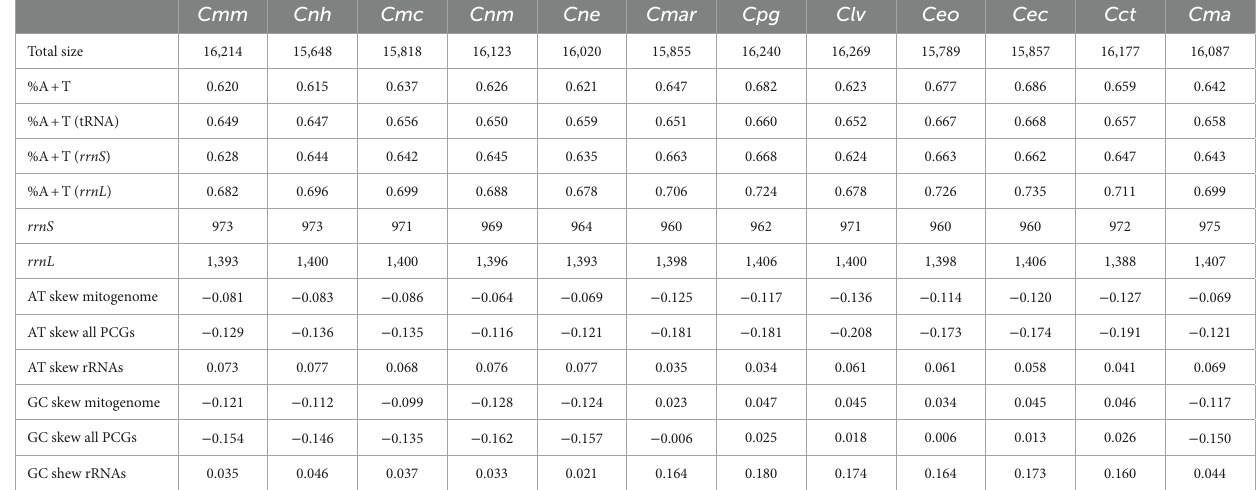
TABLE 2 List of total size, AT content, AT skew and GC skew, for mitochondrial genomes of Monetaria moneta ( Cmm ), Naria helvola ( Cnh ), Mauritia arabica ( Cmar ), Naria miliaris ( Cnm ), Naria erosa ( Cne ), Monetaria caputserpentis ( Cmc ), Purpuradusta gracilis ( Cpg ), Lyncina vitellus ( Clv ), Erronea onyx ( Ceo ), Erronea caurica ( Cec ), Cypraea tigris ( Cct ), and Monetaria annulus ( Cma